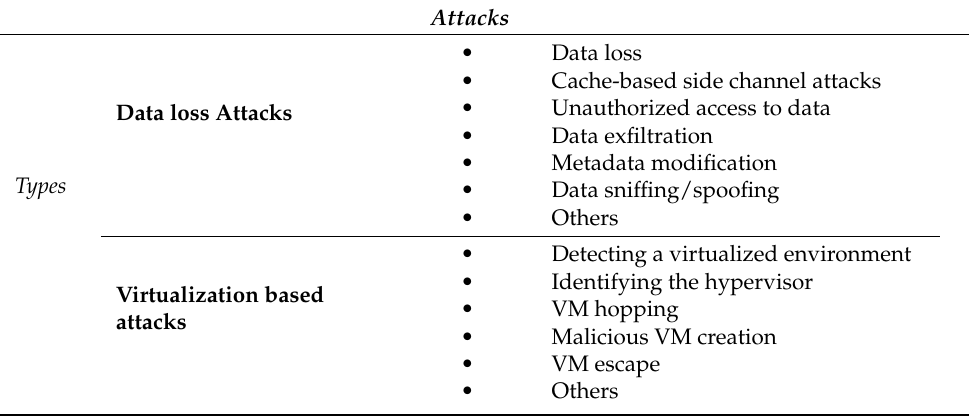
Table 1. Cloud-based